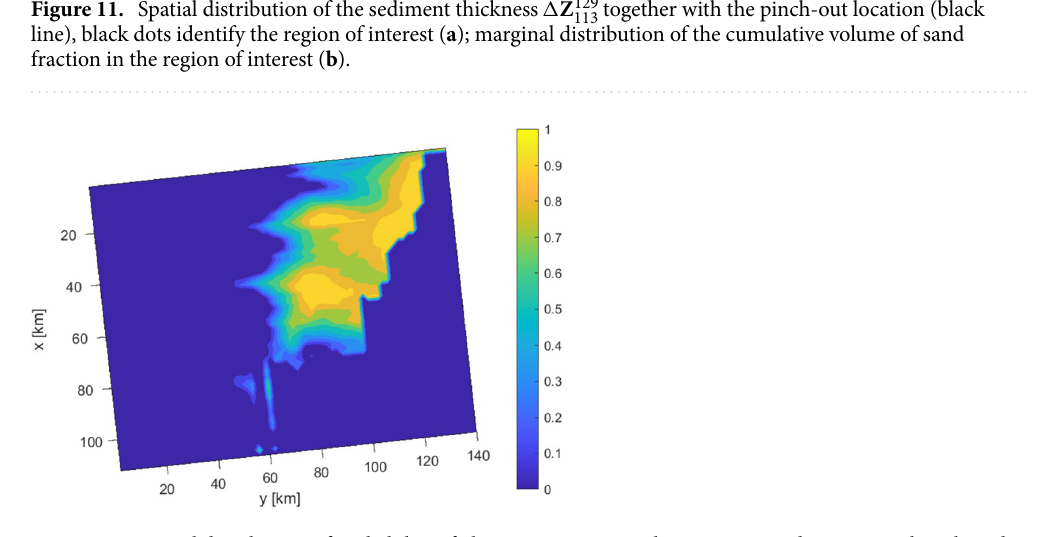
Figure 12. Spatial distribution of probability of observing V sand >20% between 129 and 113 Ma in the selected 123